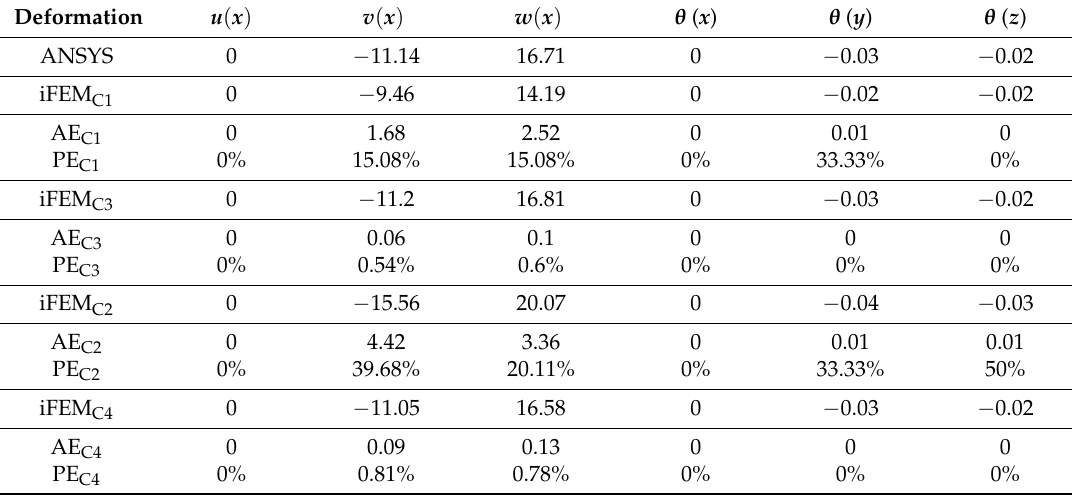
Table 3. Comparisons among deformations computed with iFEM and deformations extracted from ANSYS for uniform distribution loads (Loading